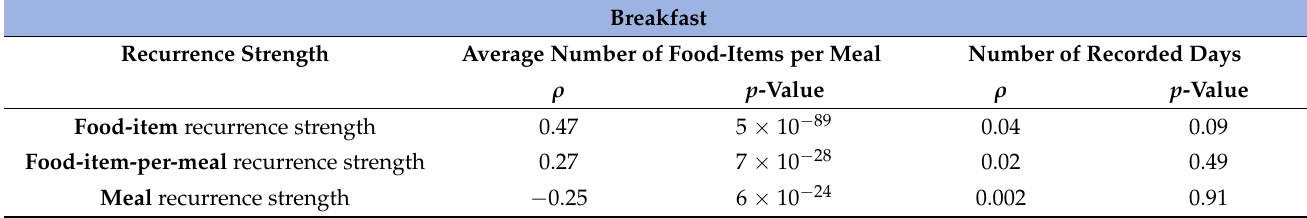
Table 4. Pearson’s correlation coefficient ρ and significance indicated by the p -value between recur- rence strength tuple and other variables for breakfast.